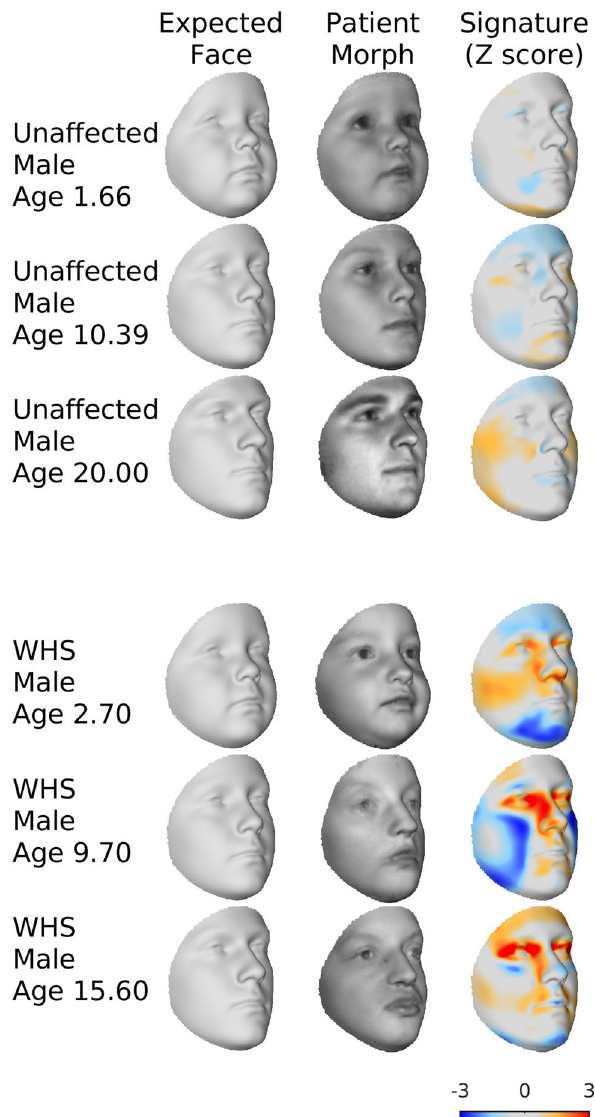
Figure 5. Assessing average patient morphs against the 3D growth curves. The first column plots the age and sex-specific expected face for the age and sex of the patient. The second plots the 3D image of the patient morph. The third plots the facial signature of the patient morph along the direction perpendicular to the expected face. Each point is colored according to the patient morph’s individual z-score. Orange and red indicates the region of the face is displaced outwardly, relative to the expected facial shape, light and dark blue indicate the point is displaced inwardly. Dark red and dark blue indicate z scores outside of the range ± 2. This figure was generated in MATLAB 2021a (https:// www. mathw orks.